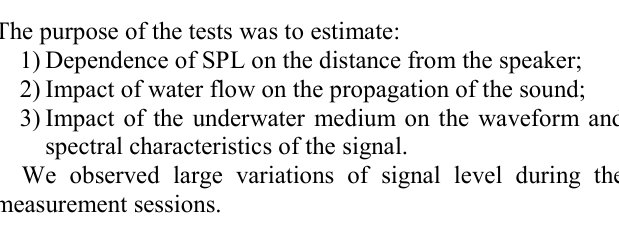
Fig. 3. Flowchart of windowing function in MCU.